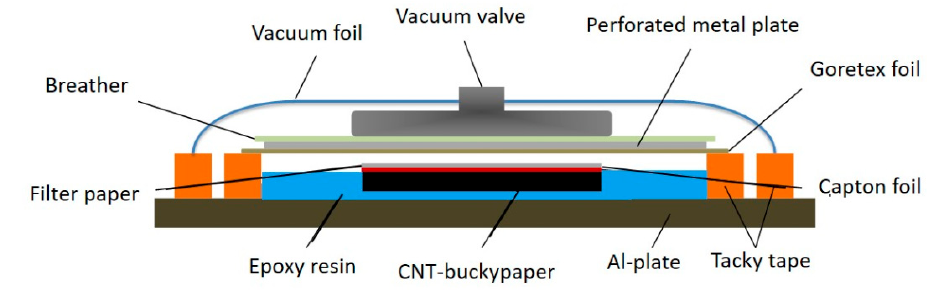
Figure 5. Scheme of the infusion set-up.